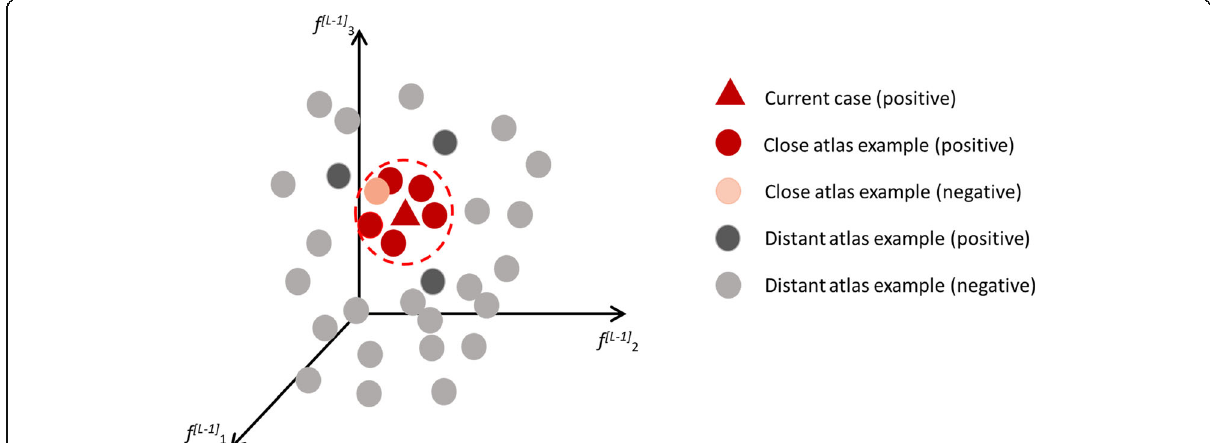
Fig. 3 The current case (red triangle) is positioned in the output feature space of L-1 layer . A neighbour region (red dashed circle) is fixed and the included training/validation annotated cases (red circles) are considered to provide reference images, classification confidence and ancillary information. Other cases outside the neighbourhood are represented as grey circles